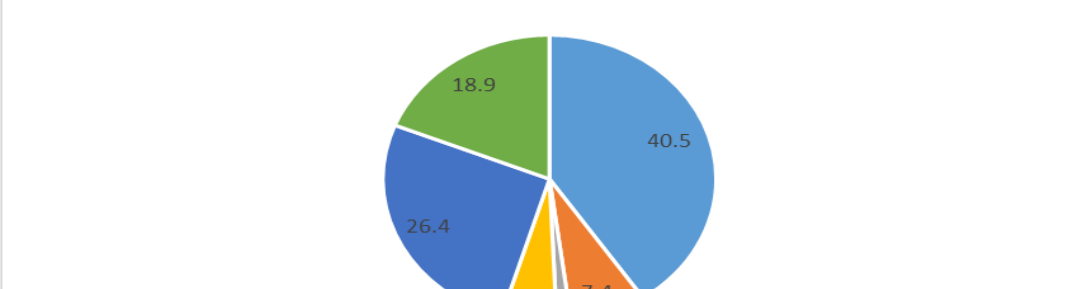
Figure 5. Outdoor-biting mosquito species collected with human bait .